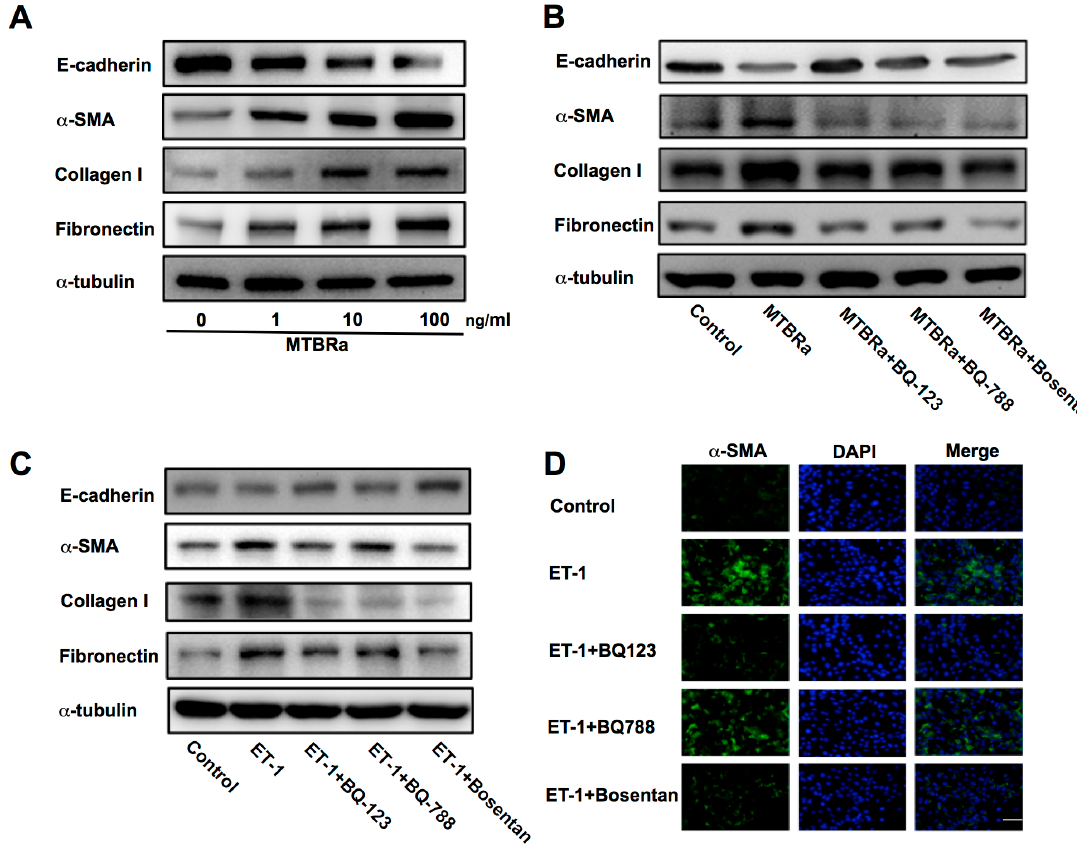
Figure 5. ET ‐ 1 mediates MTBRa ‐ induced MMT in human PMCs mainly through ET ‐ A receptor. ( A ) MeT ‐ 5A cells were treated with or without (control) indicated concentrations of MTBRa for 24 h, and E ‐ cadherin, α‐ SMA, collagen I and fibronectin were analyzed by Western blotting. ( B ) MeT ‐ 5A cells were pretreated with PBS, BQ123 (10 μ M), BQ788 (10 μ M) or Bosentan (10 μ M) for 15 min, then treated with or without (control) MTBRa (10 ng/mL) for 24 h, and E ‐ cadherin, α‐ SMA, collagen I and fibronectin were analyzed by Western blotting. ( C ) MeT ‐ 5A cells were pretreated with PBS, BQ123 (10 μ M), BQ788 (10 μ M) or Bosentan (10 μ M) for 15 min, then treated with or without (control) ET ‐ 1 (10 nM) for 24 h, and E ‐ cadherin, α‐ SMA, collagen I and fibronectin were analyzed by Western